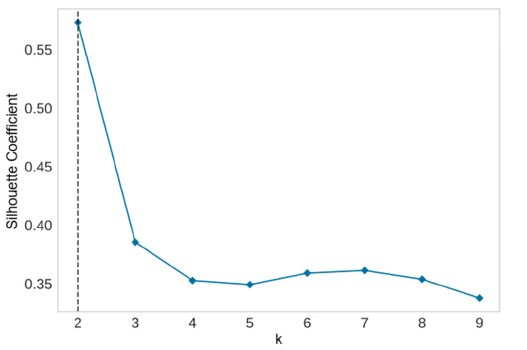
Figure 7. The optimal numbers of clusters calculated with the silhouette method for the same data as used in Figure 6.